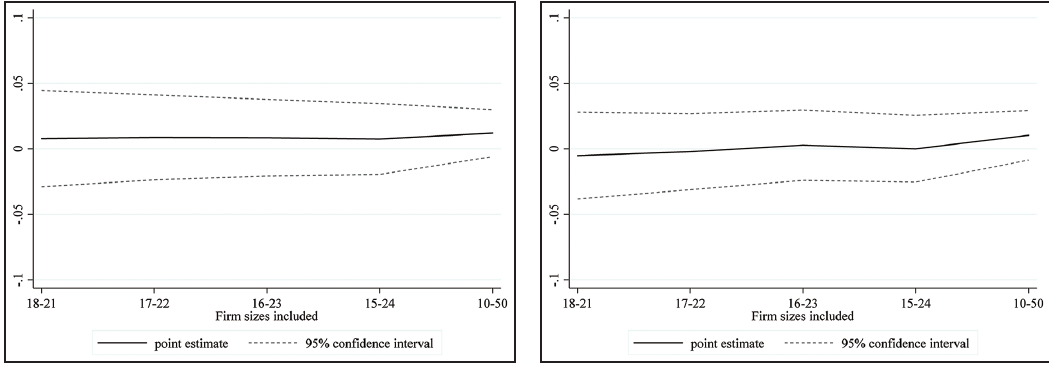
Policy effect on the number of new hires, varying firm sizes included. Panel A1: Policy effect, no cutout. Panel A2: Placebo test, no cutout. Panel B1: Policy effect, excluding firms sized 19–20. Panel B2: Placebo test, excluding firms sized 19–20. Panel C1: Policy effect, excluding firms sized 18–21 Panel C2: Placebo test, excluding firms sized